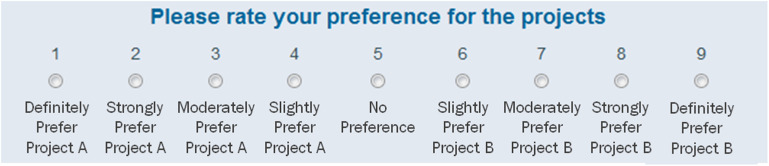
Nine-point scales used in Studies 1 and 2.